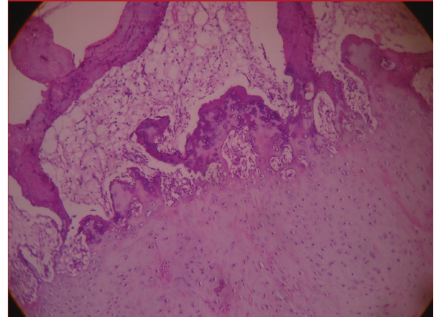
Figure 4: Microscopic view showing trabecular bone covered with a cartilaginous cap and columns of chondrocytes. Fatty connective tissue marrow is also seen (hematoxylin and eosin stain